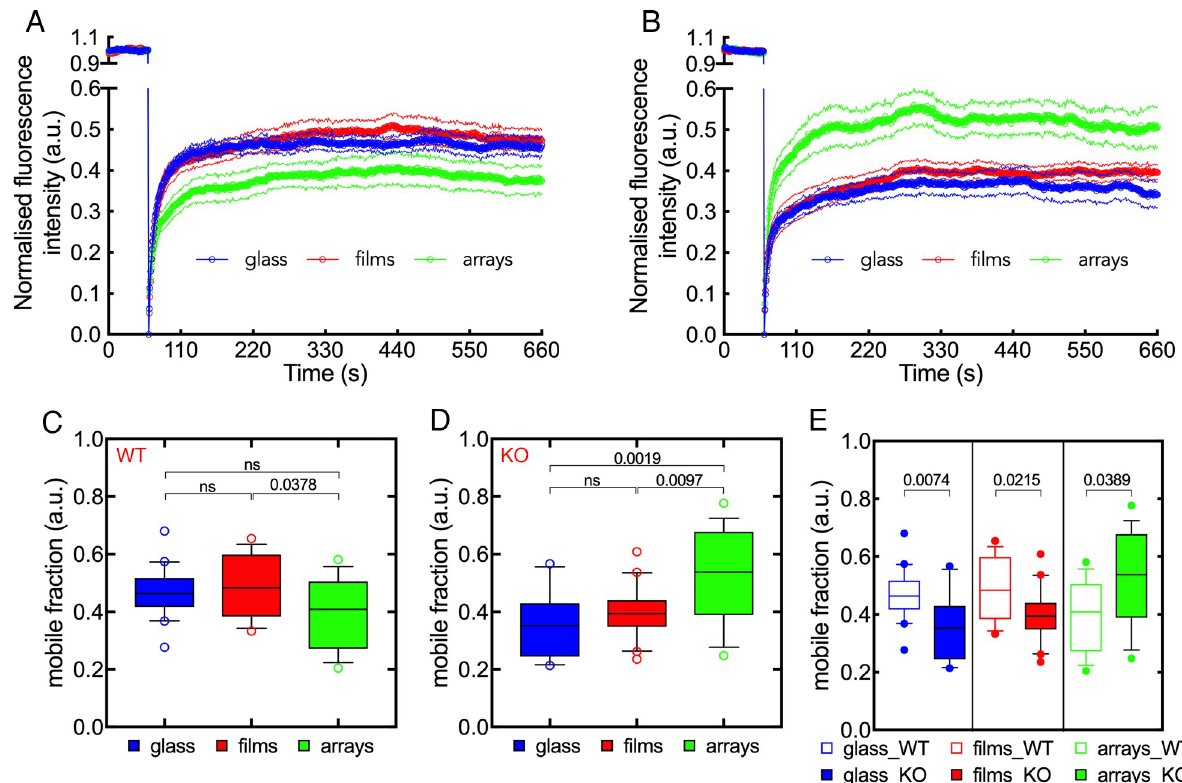
Fig 7. Effect of microgels on zyxin kinetics in wild-type and Gas2L1 KO Sertoli. (A, B) Fluorescence recovery after photobleaching showing zyxin kinetics at focal adhesions in control (A) and Gas2L1 KO (B) Sertoli cells on glass, microgel films and arrays. The lower magnitude of zyxin kinetics in control cells seeded on to microgel arrays is clear when compared to glass and microgel films substrates. In Gas2L1 KO cells, however, zyxin kinetics is higher on microgel arrays than on glass and microgel films. The thin lines above and below the thick curves indicate the standard error of the mean. (C-D) Comparison of the zyxin mobile fractions, showing a significantly reduced recovery in control cells on microgel arrays and a significantly elevated recovery in Gas2L1 KO cells. (E) Pairwise comparison of zyxin mobile fractions showing that, in Gas2L1 KO cells, zyxin kinetics are slower on glass and microgel films and faster on microgel arrays. Numbers indicate p values. ns: Not significant.